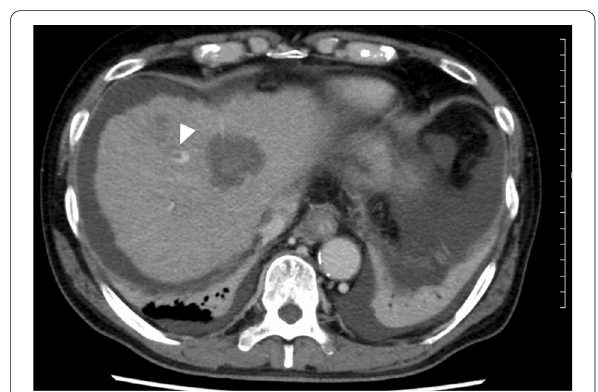
Fig. 3 Abdominal computed tomography (CT) images of case 2. An enhanced abdominal CT scan revealed thrombosis in the branches of the portal vein (white triangle) on POD